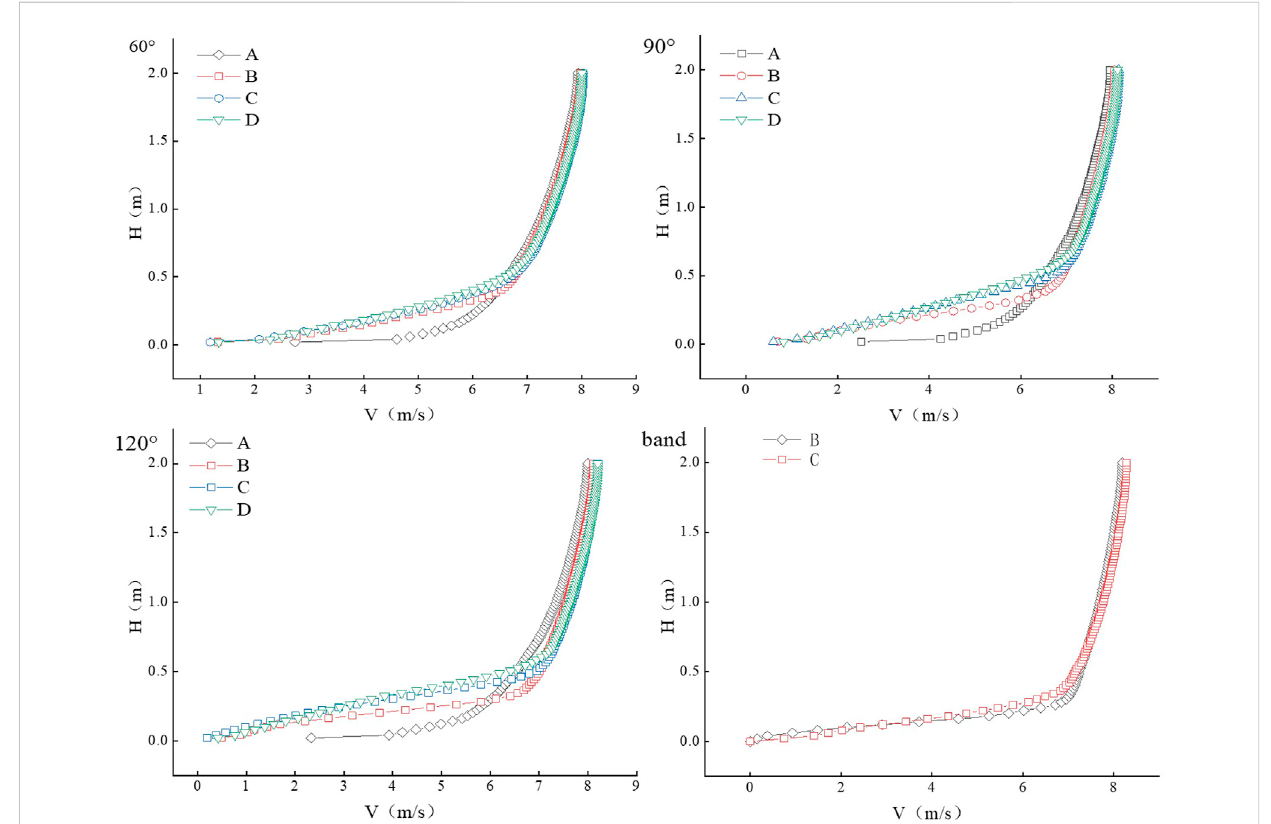
FIGURE 6 Wind velocity pro fi le of near-surface air fl ow fi eld of gauze barrier at different